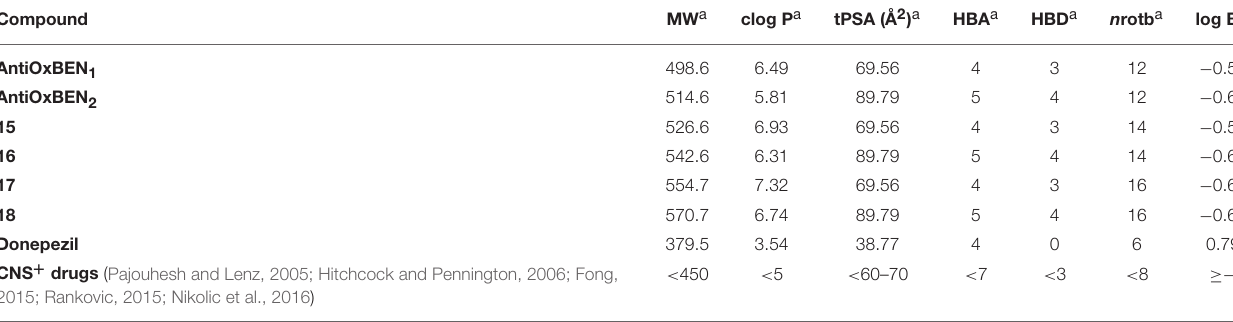
TABLE 2 | Drug-like properties of compounds AntiOxBEN 1 , AntiOxBEN 2 , 15-18 and donepezil. Compound AntiOxBEN